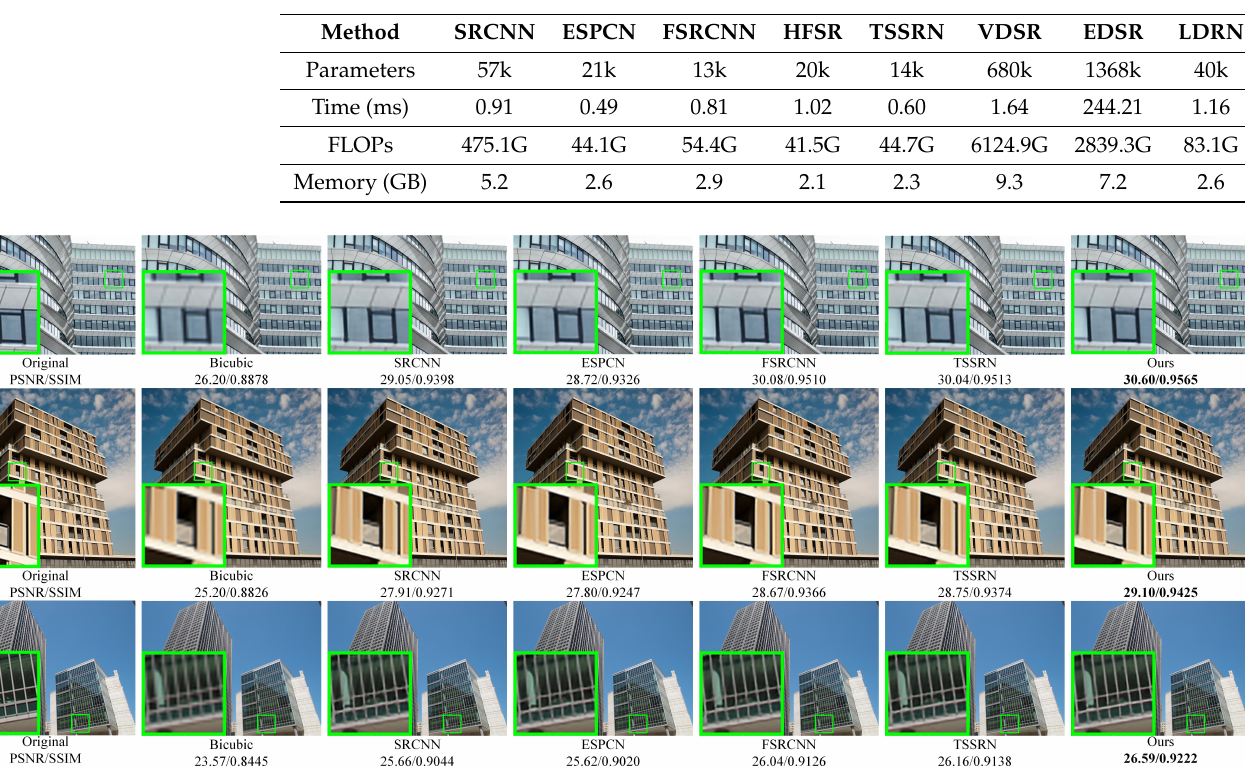
Table 5. The results of running time evaluation and parameters.